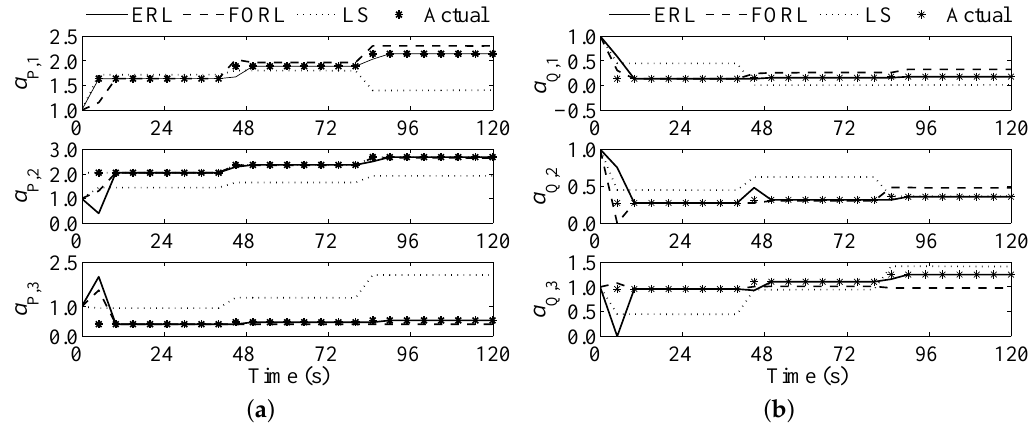
Figure 4. Coefficients for the single ZIP load. ( a ) Coefficients of active power; ( b ) coefficients of reactive power.